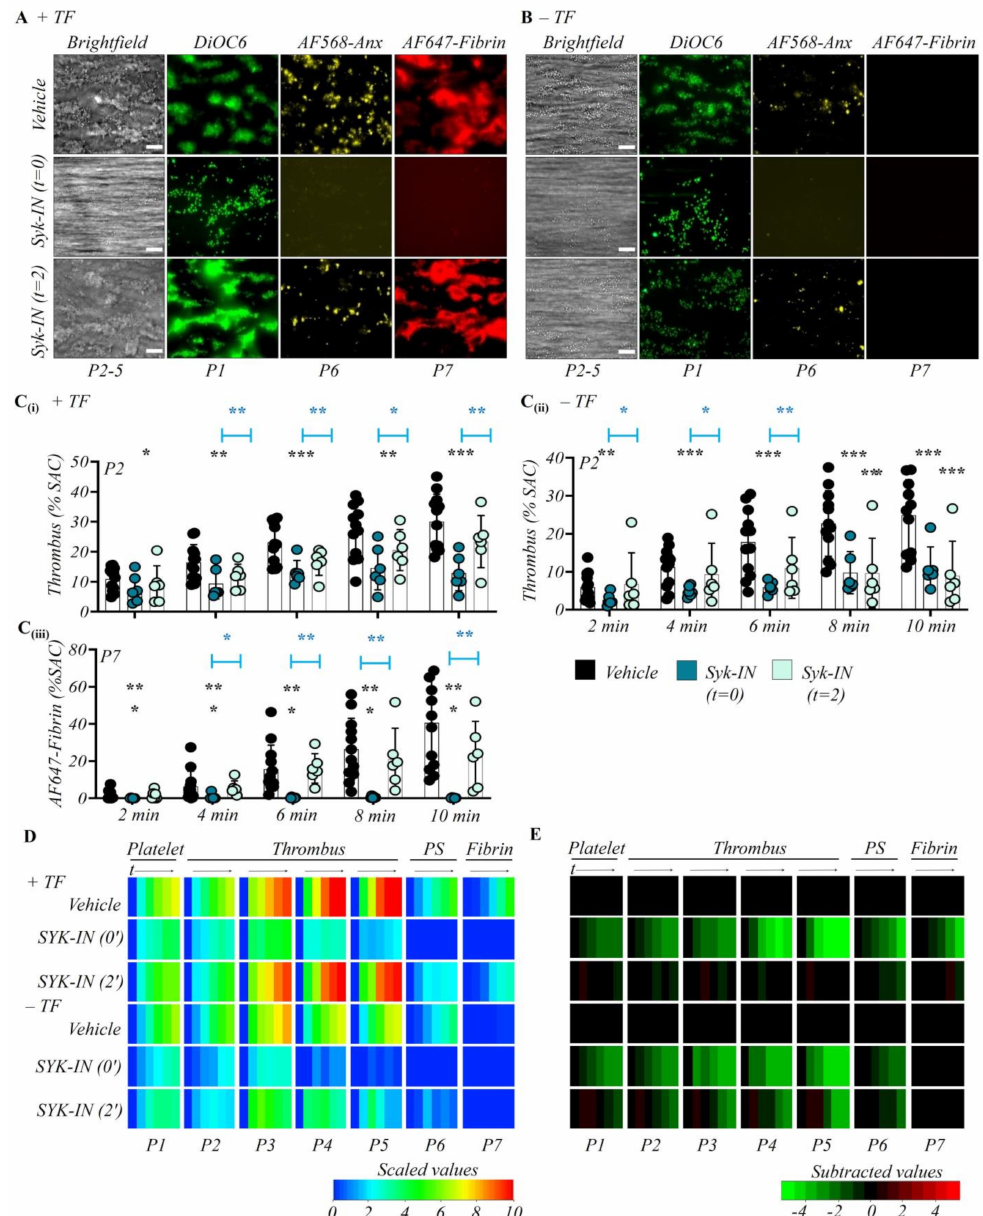
Figure 4. Time-confined role of Syk tyrosine kinase in thrombus formation. Citrated whole blood was labeled and co-perfused with recalcification medium over collagen and collagen/TF microspots ( n = 6), as for Figure 1. Where indicated, perfusion was switched from control blood to blood preincubated with vehicle or Syk-IN (PRT-060318, 20 µ M). Thrombus parameter analysis and heatmap presentation were as for Figure 1. ( A , B ) Representative end stage images of vehicle control condition; early Syk inhibition (Syk-IN from start); later Syk inhibition (Syk-IN from 2 min). Images from microspots without ( A ) or with ( B ) TF. Quantitative analysis from ± TF surfaces of parameter P2: thrombus coverage ( Ci , Cii ), and P7: fibrin deposition ( Ciii ). Means ± SD, * p < 0.05, ** p < 0.01, *** p < 0.001 vs. indicated group ( t -test). ( D ) Heatmap of univariate scaled time-dependent values per parameter (P1–7) for indicated surfaces and conditions. ( E ) Subtracted heatmap of scaled parameters versus collagen control runs. Color codes as indicated in color bars. For additional data, see Figure